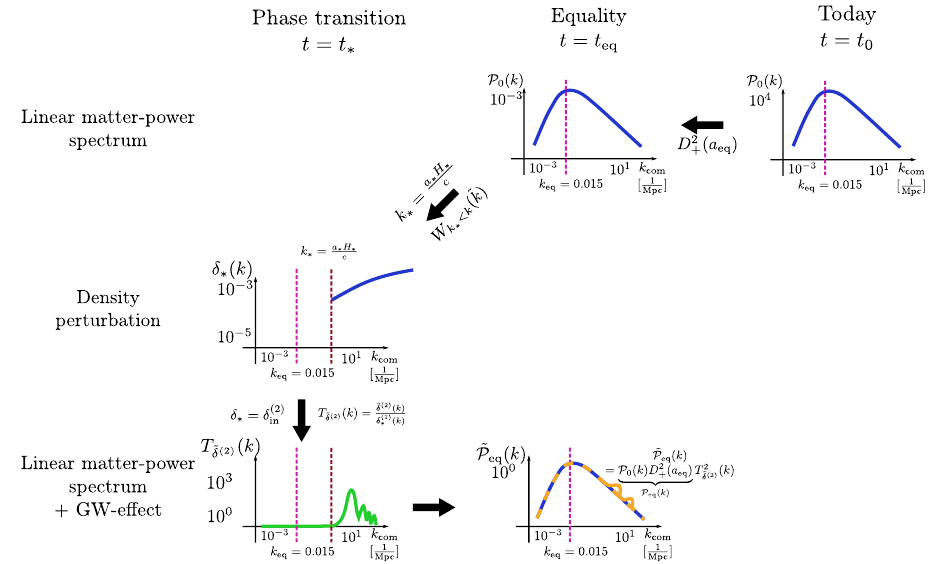
Figure 8: Schematic summary of the deduction of the matter power spectrum with the effect from gravitational wave induced second order density